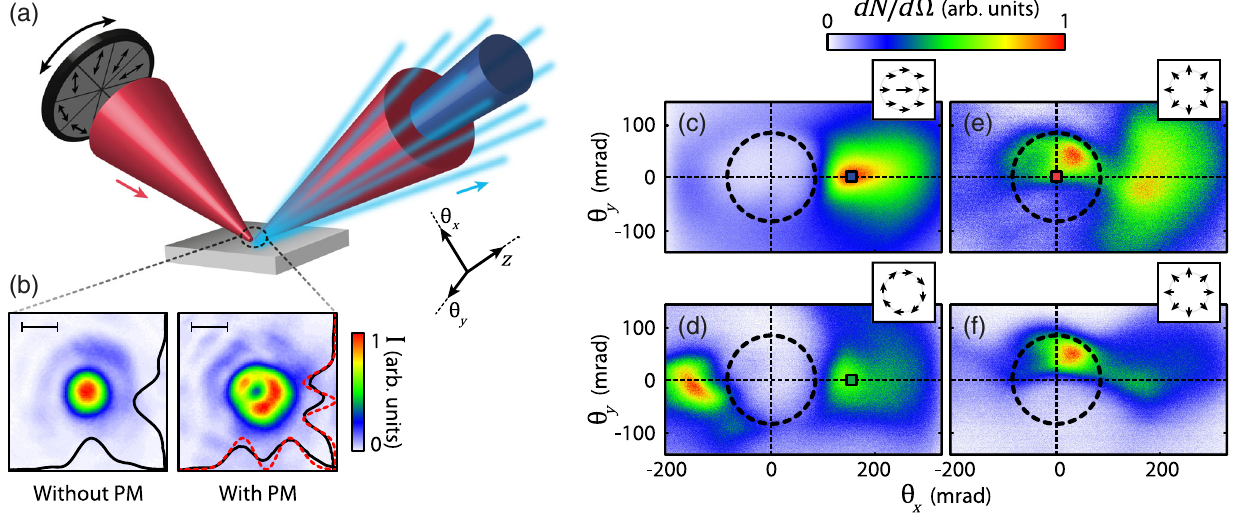
FIG. 1. (a) Sketch of the experiment. An ultraintense laser pulse (red) is reflected on the target (gray). Relativistic electrons (light blue) and high-harmonics (dark blue) are generated from the interaction and are measured simultaneously. A phase mask made of eight octants, depicted in the top-left corner, can be inserted to convert the laser polarization from linear to radial. By rotating the phase mask, the polarization can then be continuously varied from radial to azimuthal. (b) The left panel shows a focal spot for linear polarization, i.e., without the phase mask, while the right panel shows a focal spot for radial polarization. In these focal spots, a value of 1 on the color bar corresponds to 1 . 1 × 10 6 J = cm 2 for linear polarization and to 9 × 10 5 J = cm 2 for radial polarization. (c) – (f) Typical experimental angular electron distributions. The specular direction corresponds to θ x ¼ θ y ¼ 0 , while the insets depict the polarization of the laser. (c) Linear polarization: The electron beam is located between the specular and normal directions. (d) Azimuthal polarization: Electrons are located on both sides of the specular direction. (e,f) Radial polarization: Panel (e) shows a typical angular distribution, while panel (f) is a result from one of the best shots. Both distributions display an electron beam in the specular direction. The dashed black circles show the angular extent of the reflected laser beam. In these images, a value of 1 on the color bar corresponds to 100 fC = mrad 2 for panel (c), 35 fC = mrad 2 for panel (d), 22 fC = mrad 2 for panel (e), and 31 fC = mrad 2 for panel (f). See also Supplemental Material [35] for a sample of consecutive shots obtained with linear, radial, and azimuthal